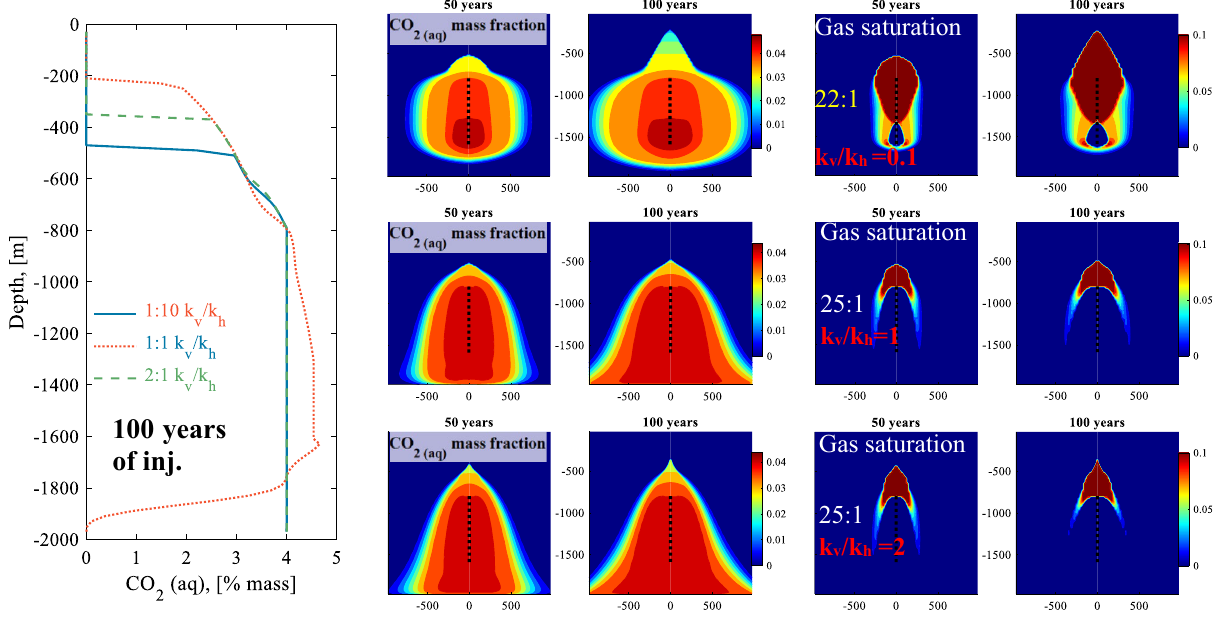
Figure 7. Left plot: Comparison of CO 2 concentration profiles at the well versus depth after 100 years of injection for systems having k v /k h ratios of 1:10, 1:1 and 2:1. The water to CO 2 injection mass ratio is 22:1 for the k v /k h ratio of 1:10, and 25:1 for the k v /k h ratio of 1:1 (reference system), and k v /k h = 2:1 as indicated in the plots.Center and right plots: 2D cross-sections for the CO 2 mass fraction and gas saturation, which is the mass fraction of exsolved CO 2 in the pore fluids, for the three modelled systems after 50 and 100 years of carbonated water